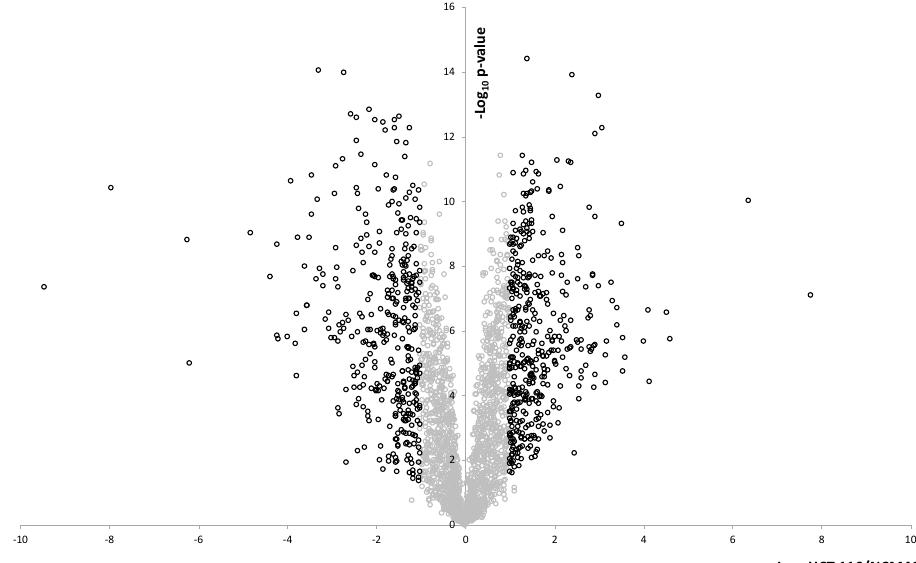
Figure 3. Proteomic analysis of NCM460 and HCT 116 using a bottom-up proteomic strategy. Proteins were analyzed by label-free quantification (LFQ) liquid chromatography–tandem mass spectrometry (LC–MS/MS). MaxQuant and Perseus were used for data analysis. The log 2 transformed relative expression levels of HCT 116 versus NCM460 are plotted on the x-axis and on the y-axis are plotted the log 10 transformed p -values. Unchanged proteins are indicated with grey circles. 901 proteins were significantly ( p < 0.05) at least 2-fold differentially expressed. 777 of these are indicated with black circles and 57 were detected in all HCT 116 samples and were below detection limit in all NCM460 samples while 67 proteins were detected in all NCM460 and were below detection limit in all HCT 116 samples. They could not be pictured in the volcano plot, but are included in supplementary Table 1.